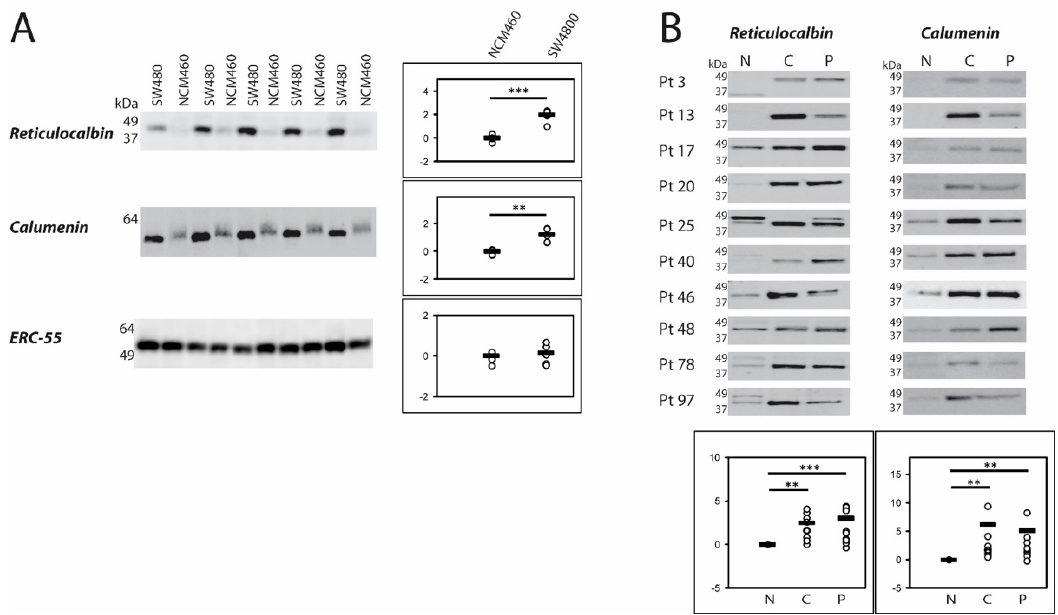
Figure 1. Western blotting of three CREC family members. ( A ) NCM460 and SW480 cells were